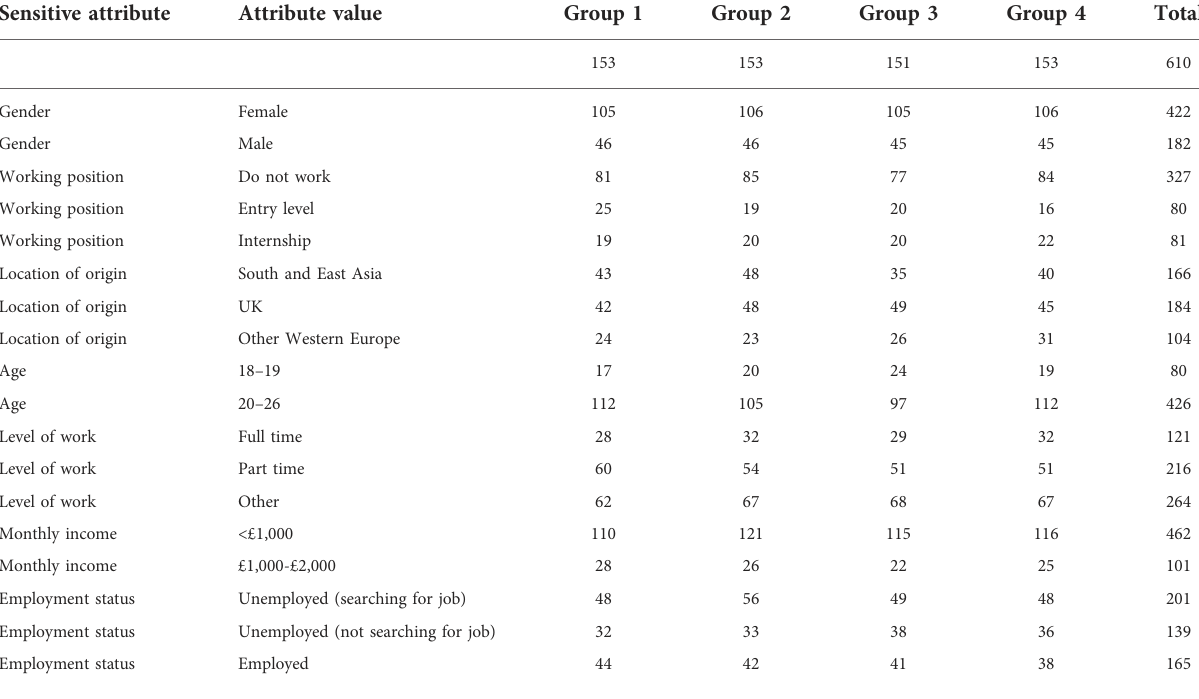
TABLE 2 Distribution of participants per arm, total and for each value of sensitive attribute. Sensitive